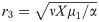
Profile likelihood for the reparameterized combination of the three-stage model.Profile of the relative negative log-likelihood (NLL) as the parameter r3=νXμ1/α is varied while the remaining parameters are fit in the three-stage clonal expansion model. The gray dotted line gives the α = 0.01 threshold for simultaneous confidence intervals based on the relative negative log-likelihood. Parameter combination r3 is identifiable.